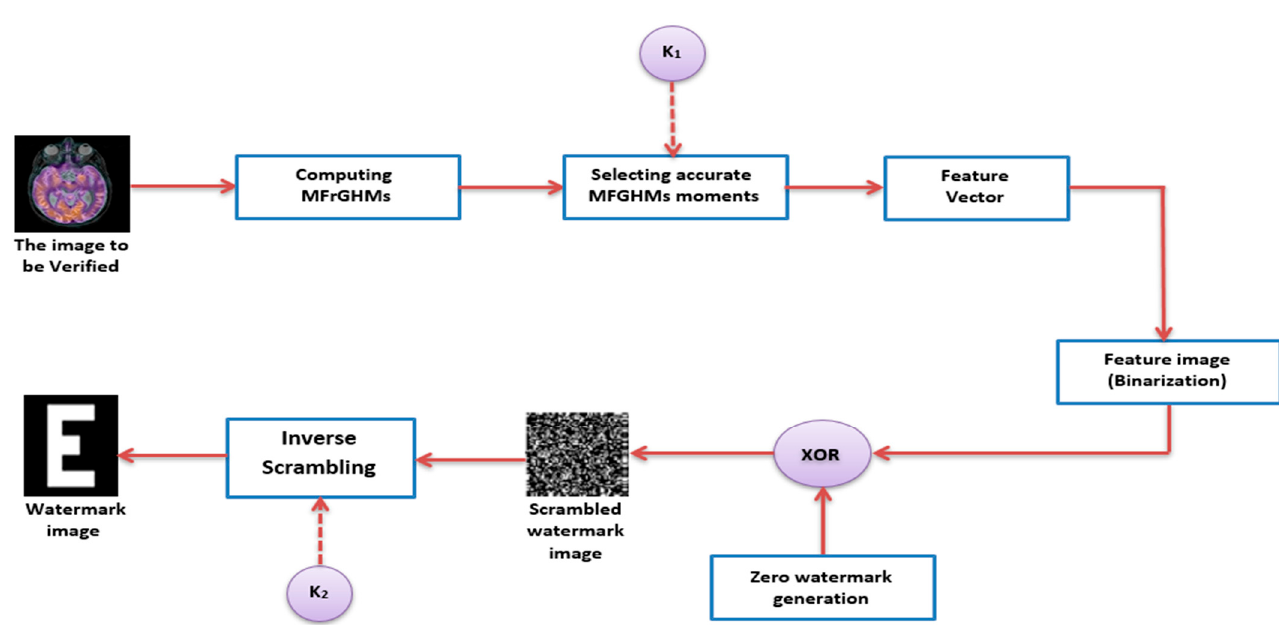
Figure 2. Zero-watermarking verification framework.